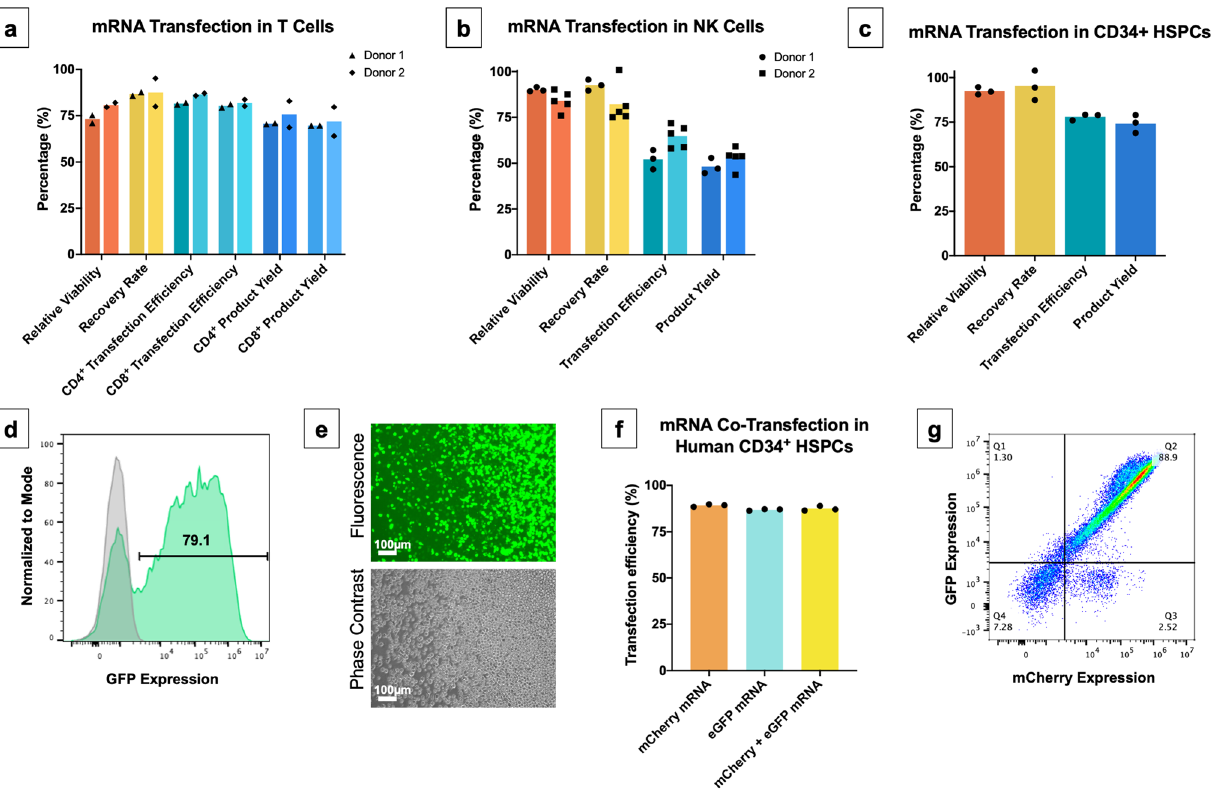
Figure 4. Optimized mRNA transfection results for T cells, NK cells and HSPCs; assessed by relative viability, recovery rate, transfection efficiency and product yield. ( a ) GFP mRNA transfection result in human T cells (two donors). T cells were isolated, activated and transfected with VECT. Transfection efficiency in CD4 + and CD8 + populations was obtained by flow cytometry after staining CD4 + and CD8 + markers with fluorescently labelled antibodies. ( b ) GFP mRNA transfection results for expanded human NK cells (two donors). ( c ) GFP mRNA transfection results for mobilized peripheral blood CD34 + -selected human HSPCs (one donor). ( d ) Representative histogram of HSPC transfection with GFP mRNA, where transfection efficiency was measured by means of detection of GFP fluorescence by flow cytometry. ( e ) Representative picture of HSPC GFP fluorescence signal as captured under fluorescence microscope. ( f ) Comparison of the delivery of single mRNA molecules encoding for mCherry and eGFP versus co-delivery of the same two mRNA molecules in HSPCs. ( g ) Representative flow cytometry dot plot for the co-delivery of eGFP mRNA (y axis) and mCherry mRNA (x